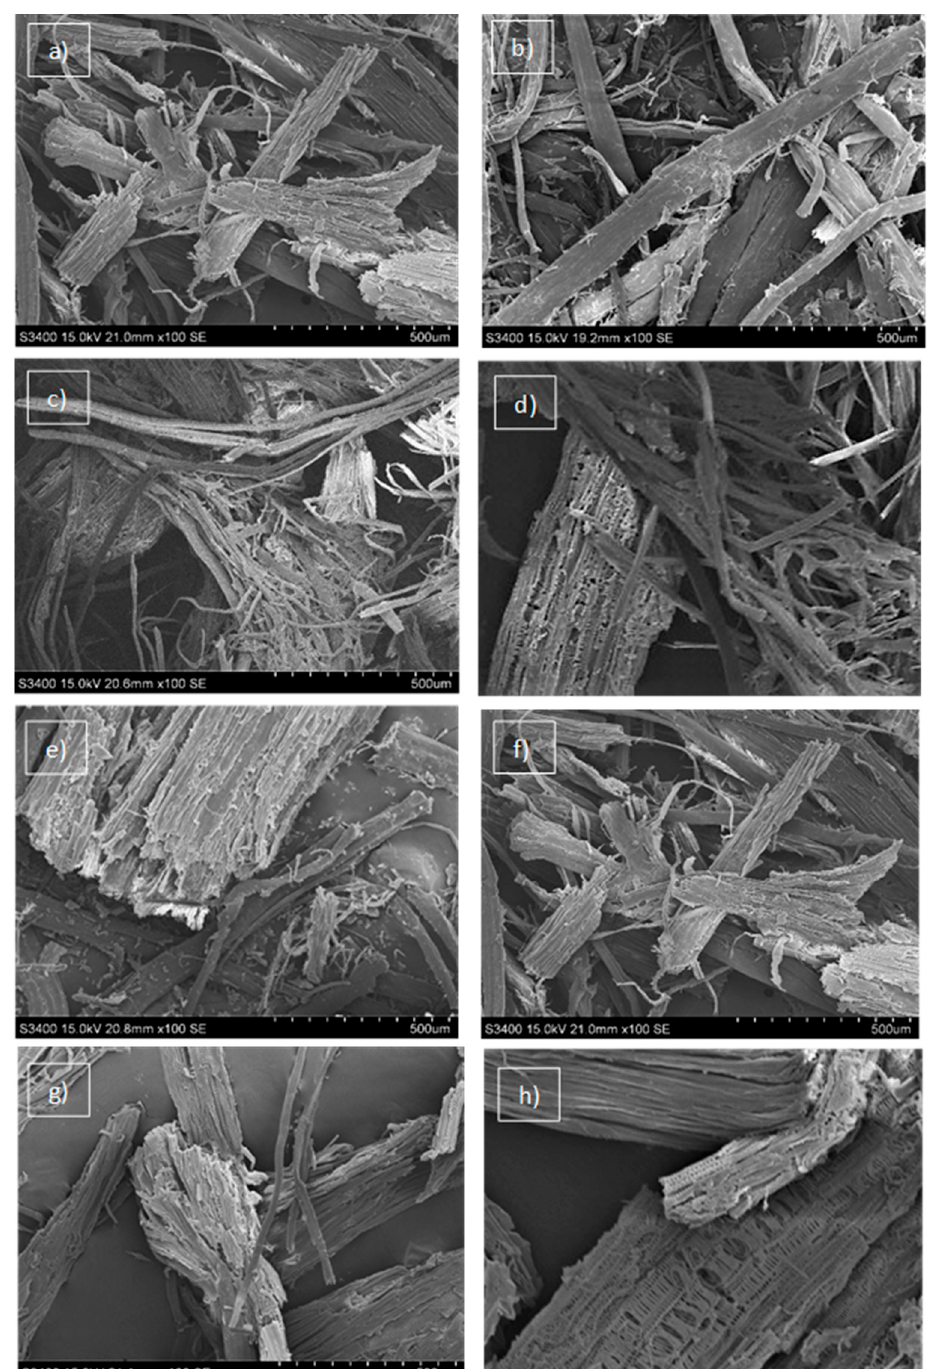
Figure 2. The SEM images of hemp biomass: ( a ) Tygra biomass before pretreatment, ( b ) Tygra biomass after pretreatment, ( c ) Tygra biomass after enzymatic hydrolysis, ( d ) Tygra biomass after enzymatic hydrolysis—selected fragment in high magnification, ( e ) Rajan biomass before pretreatment, ( f ) Rajan biomass after pretreatment, ( g ) Rajan biomass after enzymatic hydrolysis, ( h ) Rajan biomass after enzymatic hydrolysis—selected fragment in high magnification.